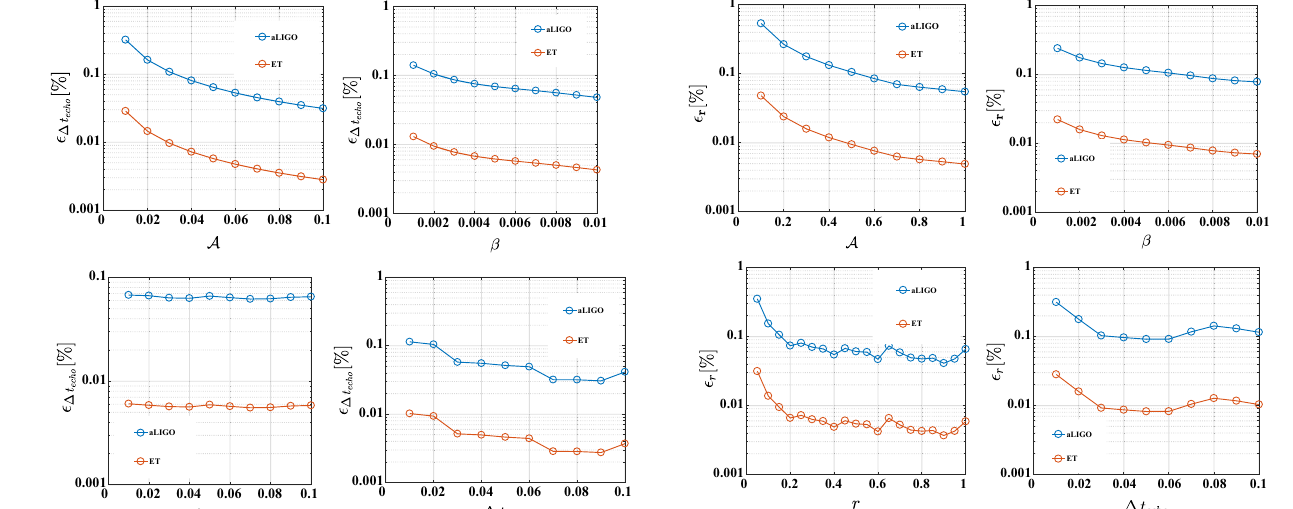
β = 0 . 001 is 7.28, which increases to 24 . 68 when β = 0 . 01.